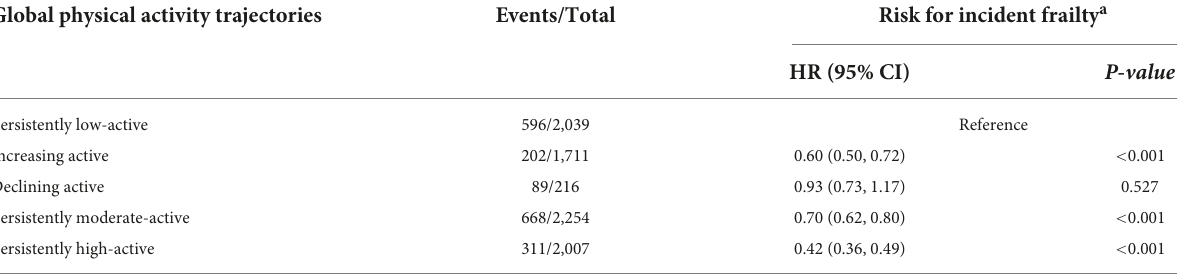
TABLE 3 Hazard ratios and 95% confidence intervals of incident frailty by global physical activity